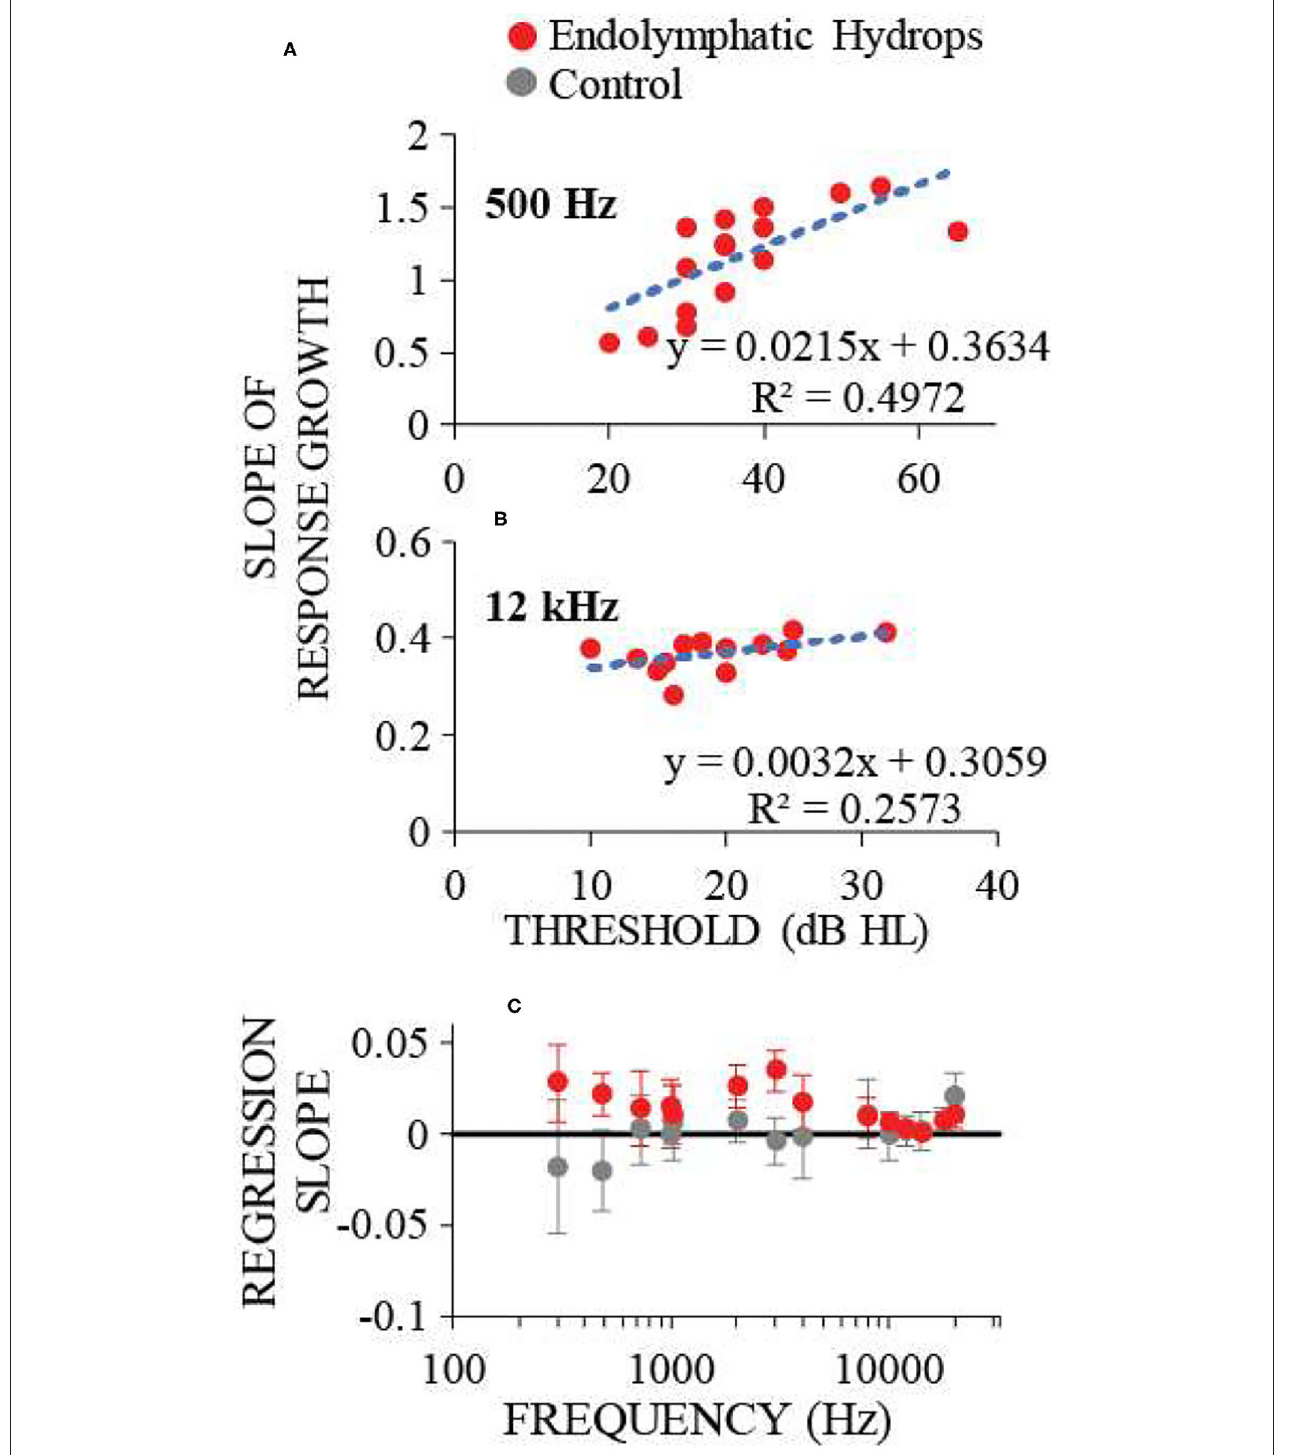
FIGURE 5 | The dependence on hearing threshold of the slope metric of response recruitment. (A,B) show the slope metric for response recruitment vs. the threshold of that ear at the test frequency, for two example frequencies with one point for each ear operated on to remove the endolymphatic sac. Dotted lines are linear regressions to the points; regression line coefficients and the R 2 value for the regression are shown at the panel lower right. (C) shows the regression-line slope coefficients averaged across ears for each frequency, for operated (red) and control (gray) ears. Error bars are 95% confidence intervals. Response recruitment varied with hearing threshold at low and mid frequencies where hearing thresholds were elevated, but not at high frequencies where hearing thresholds were within normal limits.